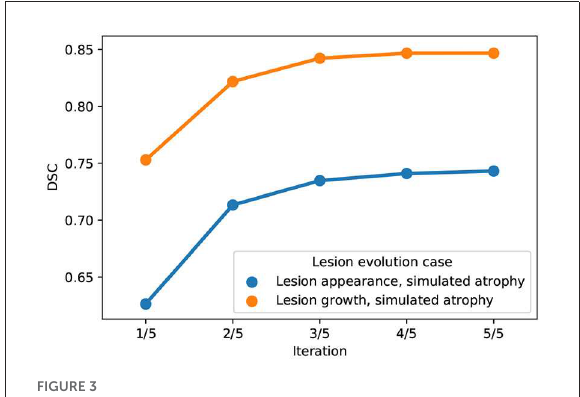
FIGURE3 Evolution of DSC across iterations of the alternating optimization scheme of the joint approach on the synthetic dataset (blue: Lesion appearance, simulated atrophy, orange: Lesion growth, simulated